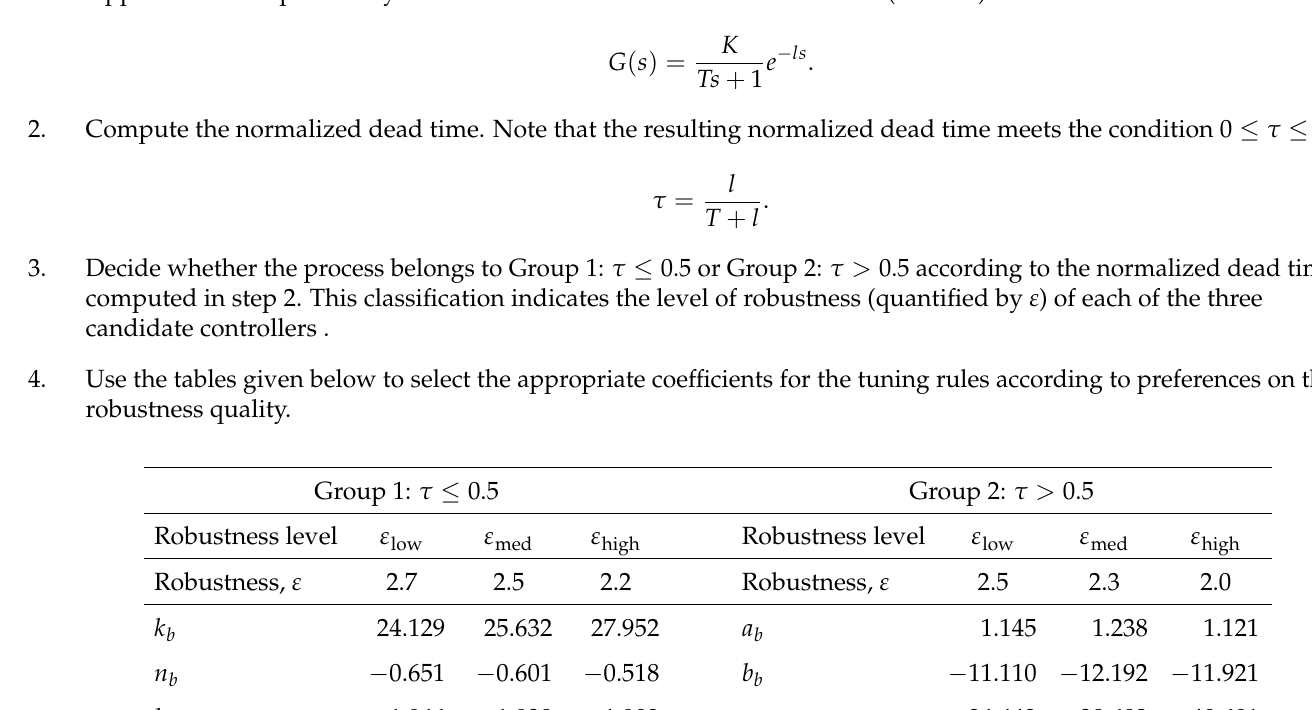
Table 3. LADRC tuning